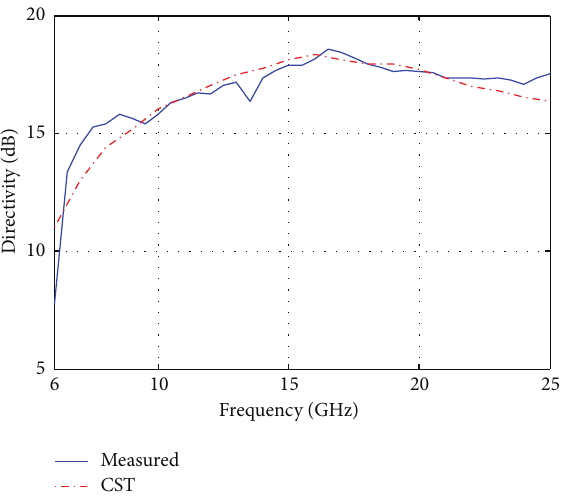
Figure 5: Measured and simulated directivities of the